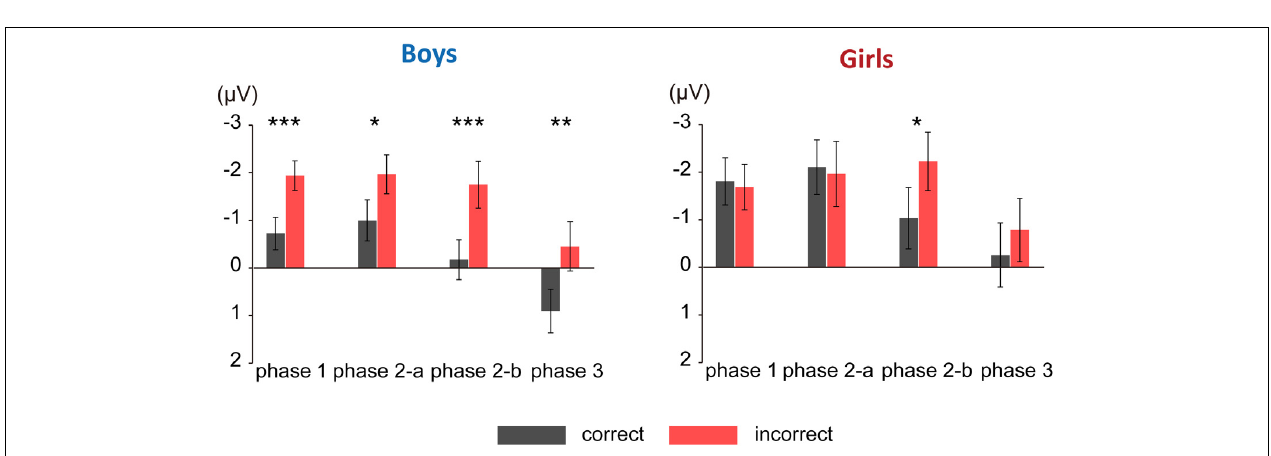
FIGURE 3 | Grand-average ERPs at the onset of the second phrase. Five exploring electrodes were placed based on the international 10–20 system. Negative voltage is plotted up. Red lines denote the average amplitude for incorrect sentences and black lines denote that for correct sentences. Left : grand-average ERPs for boys; right : grand-average ERPs for girls.